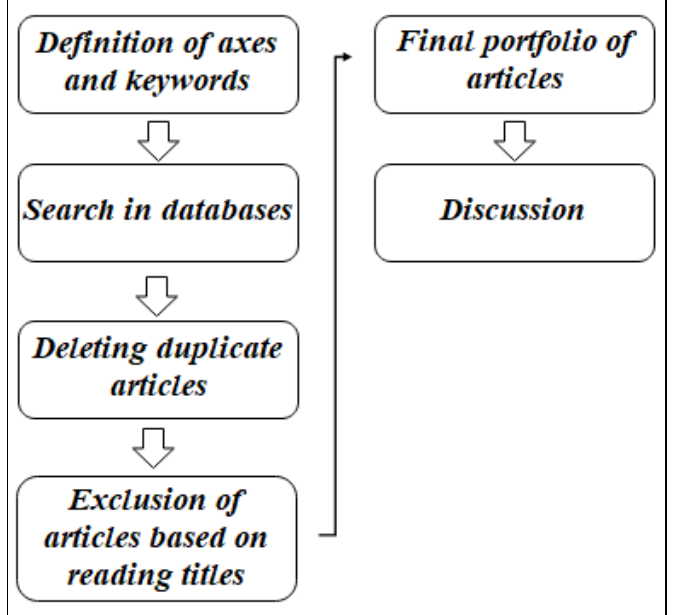
Figure 1: Flowchart used in the criteria for choosing the studies.